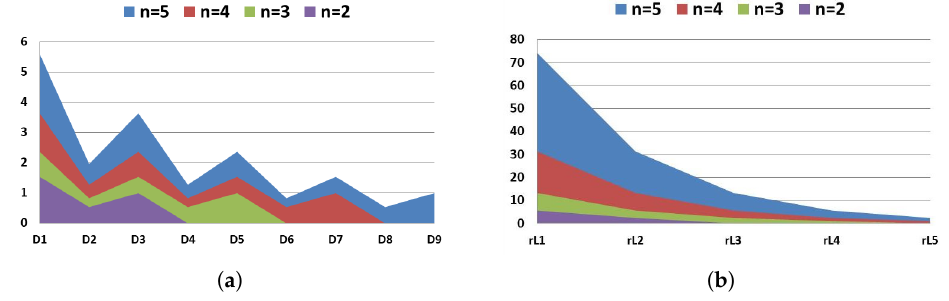
Figure 3. The value of K D